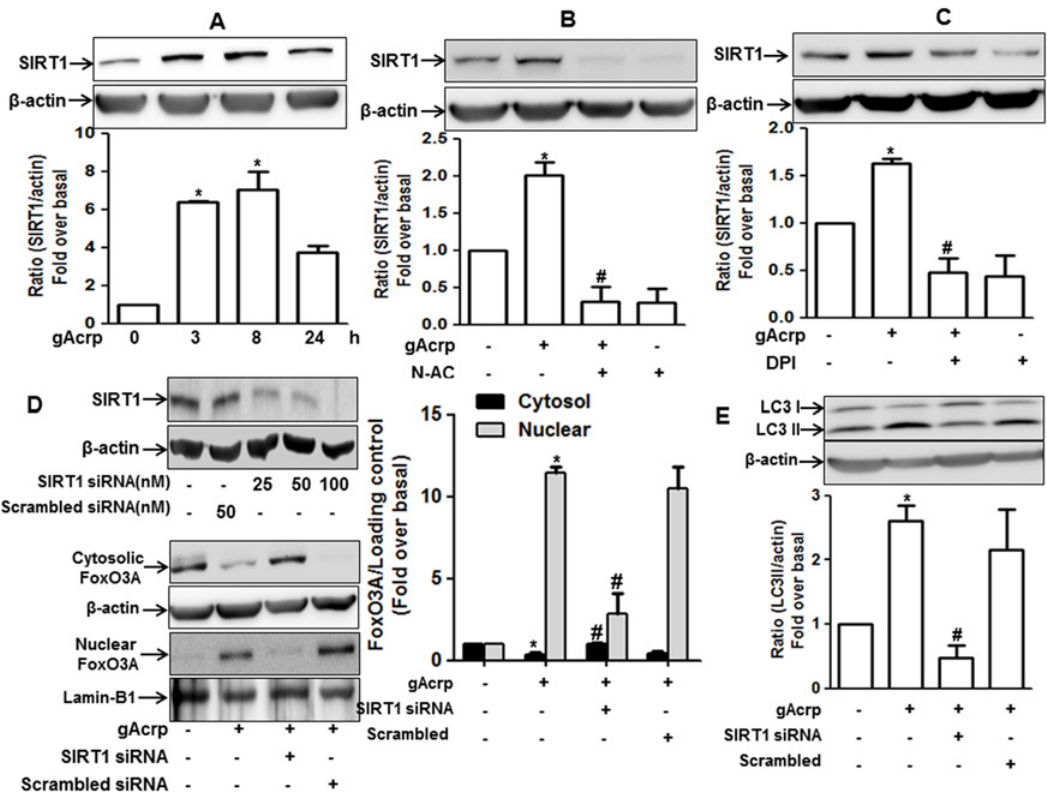
Fig 7. Role of SIRT1 in gAcrp-induced FoxO3A nuclear translocation and autophagy induction in RAW 264.7 macrophages. (A) Cells were treated with gAcrp (1 μ g/ml) for indicated time periods. SIRT1 protein expression was determined by Western blot analysis as described previously. (B and C) Cells were pretreated with N-AC (B) or DPI (C) for 1 h followed by treatment with gAcrp (1 μ g/ml) for additional 8 h. Western blot analysis was performed to determine SIRT1 protein expression level. Representative images of three independent experiments are shown, keeping β -actin as an internal loading control. Quantitative analysis for SIRT1 expression was performed by densitometric analysis and presented as mean ± S.E.M. (n = 3). * P < 0.05 compared with control; # P < 0.05 compared to cells treated with gAcrp. (D) (Upper panel) Cells were transfected with indicated concentration of siRNA targeting SIRT1 or scrambled control siRNA. Gene silencing efficiency was measured by Western blot analysis. (Lower panel) After transfection with SIRT1 siRNA or scrambled siRNA, cells were treated with gAcrp (1 μ g/ml) for 24 h. FoxO3A protein expression levels in cytosol and nucleus were determined by Western blot analysis along with β -actin and lamin B1 as internal loading control for cytosolic and nuclear respectively. Images are representative of three independent experiments. Densitometric analysis was done to quantitate protein and is shown in the graph (right panel) and values are presented as mean ± S.E.M. (n = 3). * P < 0.05 compared with control; # P < 0.05 compared to cells treated with gAcrp in the cytosol and nucleus fraction. (E) RAW 264.7 macrophages were treated with SIRT1 siRNA and gAcrp essentially same as above. LC3II expression level was monitored by Western blot analysis as described previously. Quantitative analysis for FoxO3A and LC3II protein expression were performed by densitometric analysis and are shown in the graph (lower panel of each figure). Values are expressed as mean ± SEM (n = 3). * P < 0.05 compared with control; # P < 0.05 compared to cells treated with gAcrp.